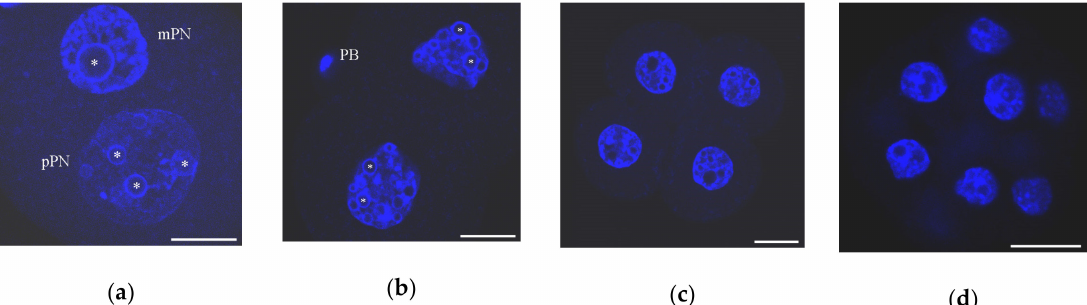
Figure 3. Chromatin organization in mouse early embryos developing in vivo as viewed after DAPI staining: ( a ) zygote, 27 h after peritoneal injection of human chorionic gonadotropin (hCG); mPN, maternal pronucleus; pPN, paternal pronucleus; heterochromatin rings are visible in both PNs around nucleolus-precursor bodies (NPBs); ( b ) two-cell stage, 46 h post-hCG; PB, polar body; chromocenters begin to form at this stage; ( c ) four-cell stage, 55 h post-hCG; numerous chromocenters are visible; heterochromatin rings begin to disappear around some NPBs; and ( d ) morula, 72 h post-hCG. Some typical NPBs are marked by asterisks. Scale bars represent 20 µ